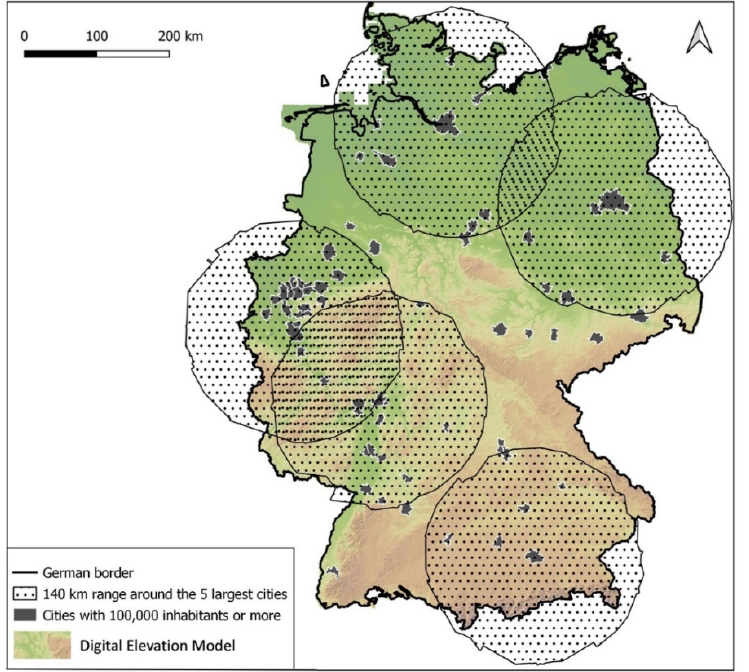
Figure 7. Map of Germany with a digital elevation model indicating topography around five cities in Germany with the highest population numbers.